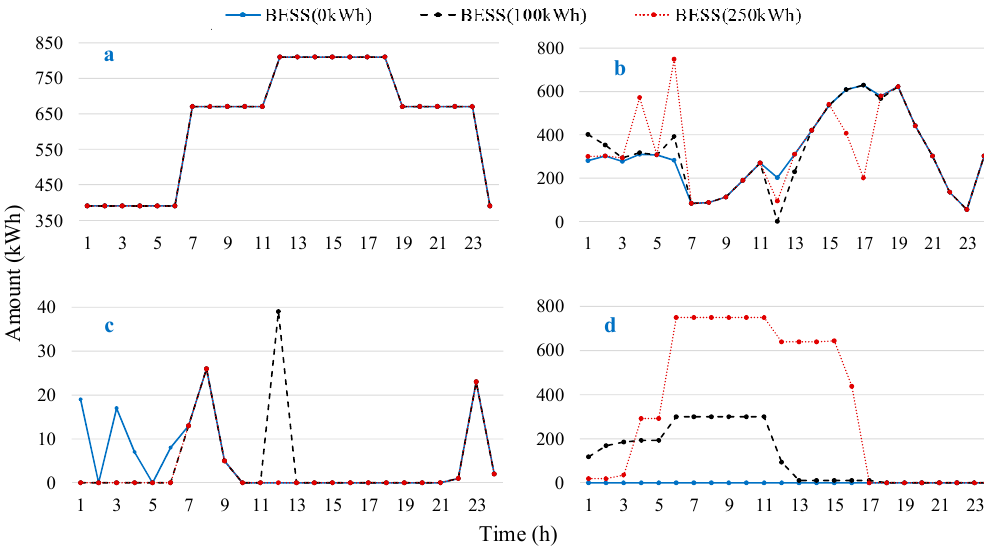
Figure 7. ( a ) Generation of CDGs; ( b ) external power trading; ( c ) internal power transfer; ( d ) BESS